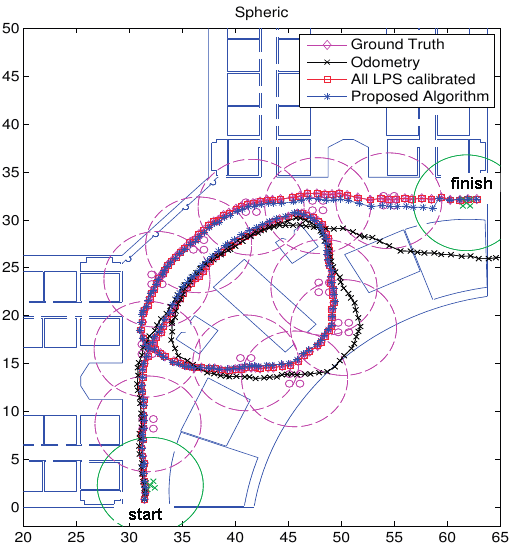
Figure 6. Simulated trajectory. ( Left ) Spherical case; ( right ) hyperbolic